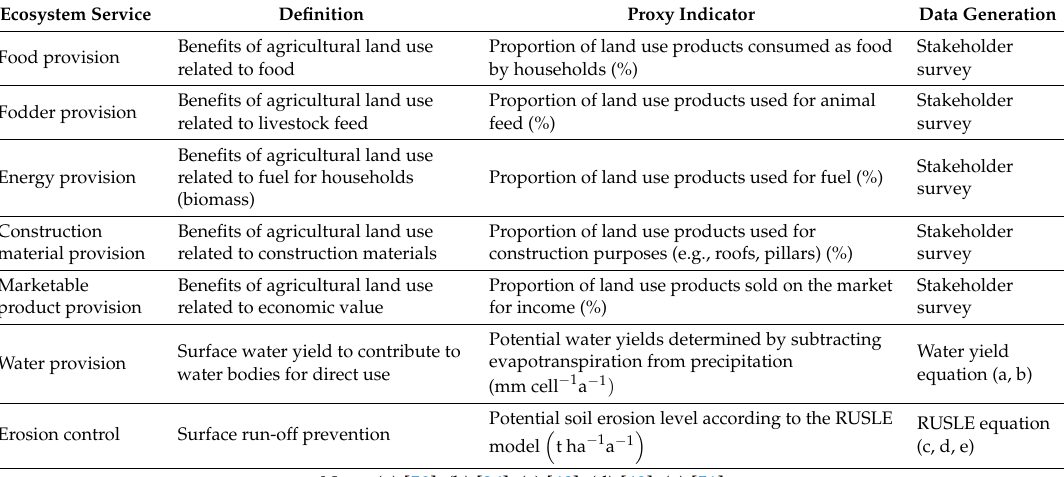
Table 2. Selected ecosystem services, indicators, and data generation methods for indicator